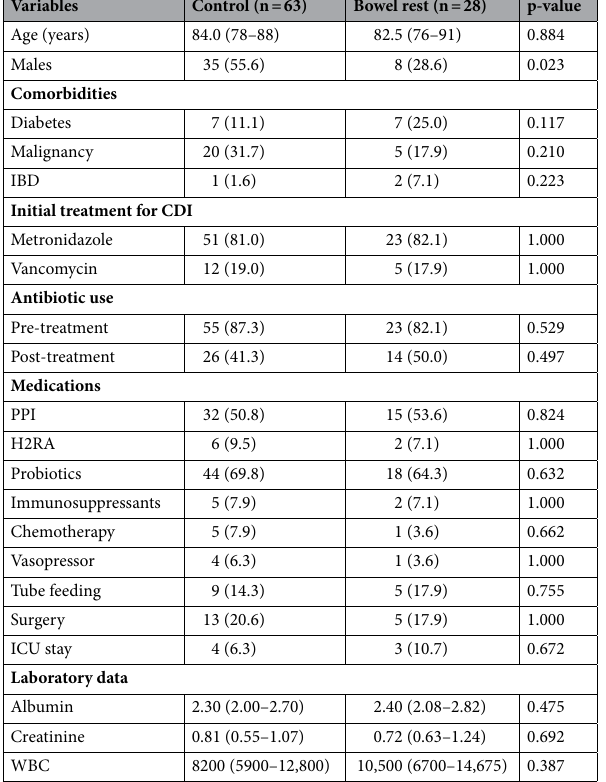
Table 1. Clinical characteristics of the full study cohort. Data are median (interquartile range) or number (%). IBD inflammatory bowel disease, CDI Clostridioides difficile infection, PPI proton pump inhibitor,